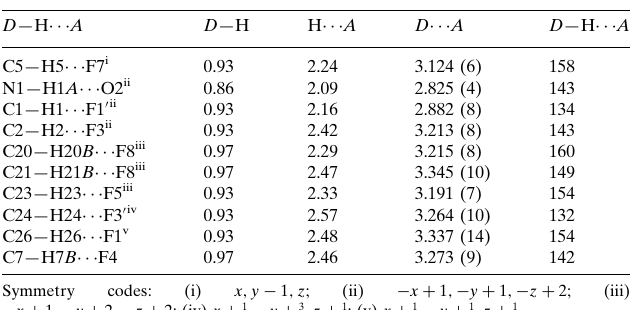
Hydrogen-bond geometry (A˚ , (cid:3)